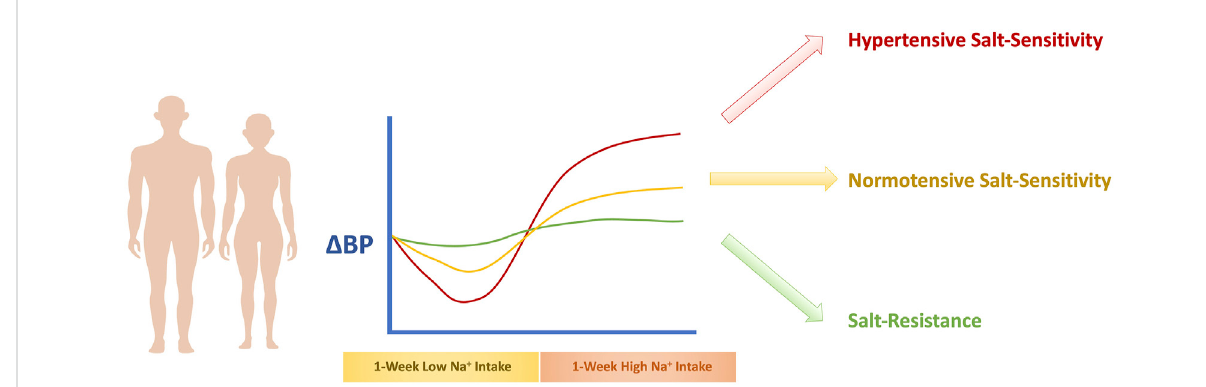
FIGURE 1 Determination of Salt-Sensitivity of BP. The recommended method to diagnose salt-sensitivity involves exposure to a 1-week high salt diet phasefollowedbya1-weeklowsaltdietphase,thatisaccompaniedwithBPmeasurements.IftheBPincreaseisequaltoorexceeds3 – 5 mmHg,the individual is considered a normotensive salt-sensitive individual. If the BP change is below 3 – 5 mmHg, the individual is considered salt-resistant. If the BP change is equal to or exceeds 8 – 10 mm Hg, the individual is classi fi ed as a hypertensive salt-sensitive